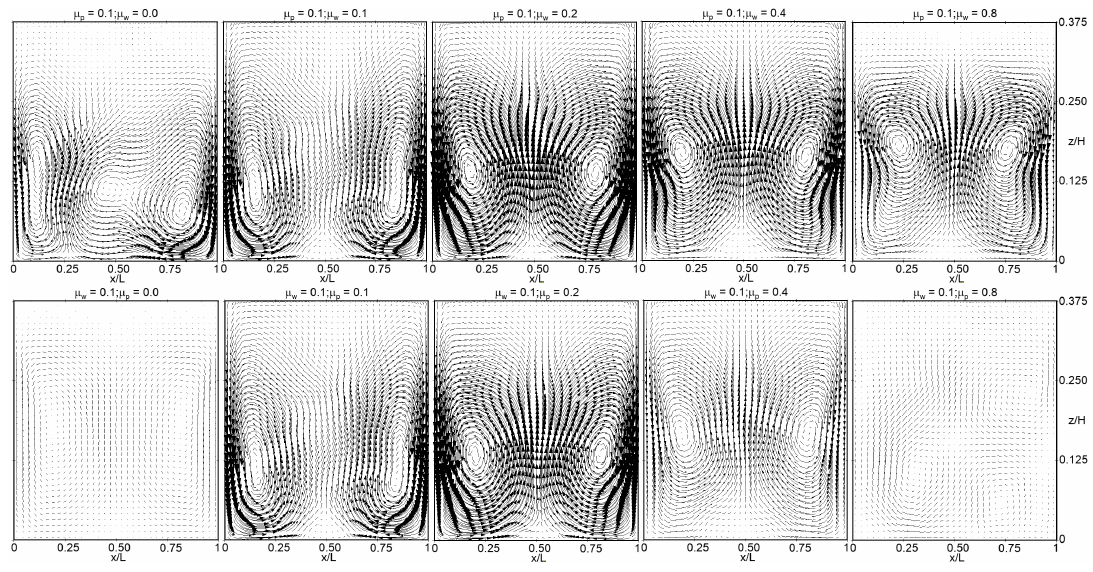
Figure 17. Time-averaged solid mass flux, < α p ρ p U p > xz , for different values of the particle–wall µ w and the particle–particle µ p friction coefficients. Upper panel: constant µ p and different µ w . Bottom panel: constant µ w and different µ p . Re p = 70 and bed weight 75